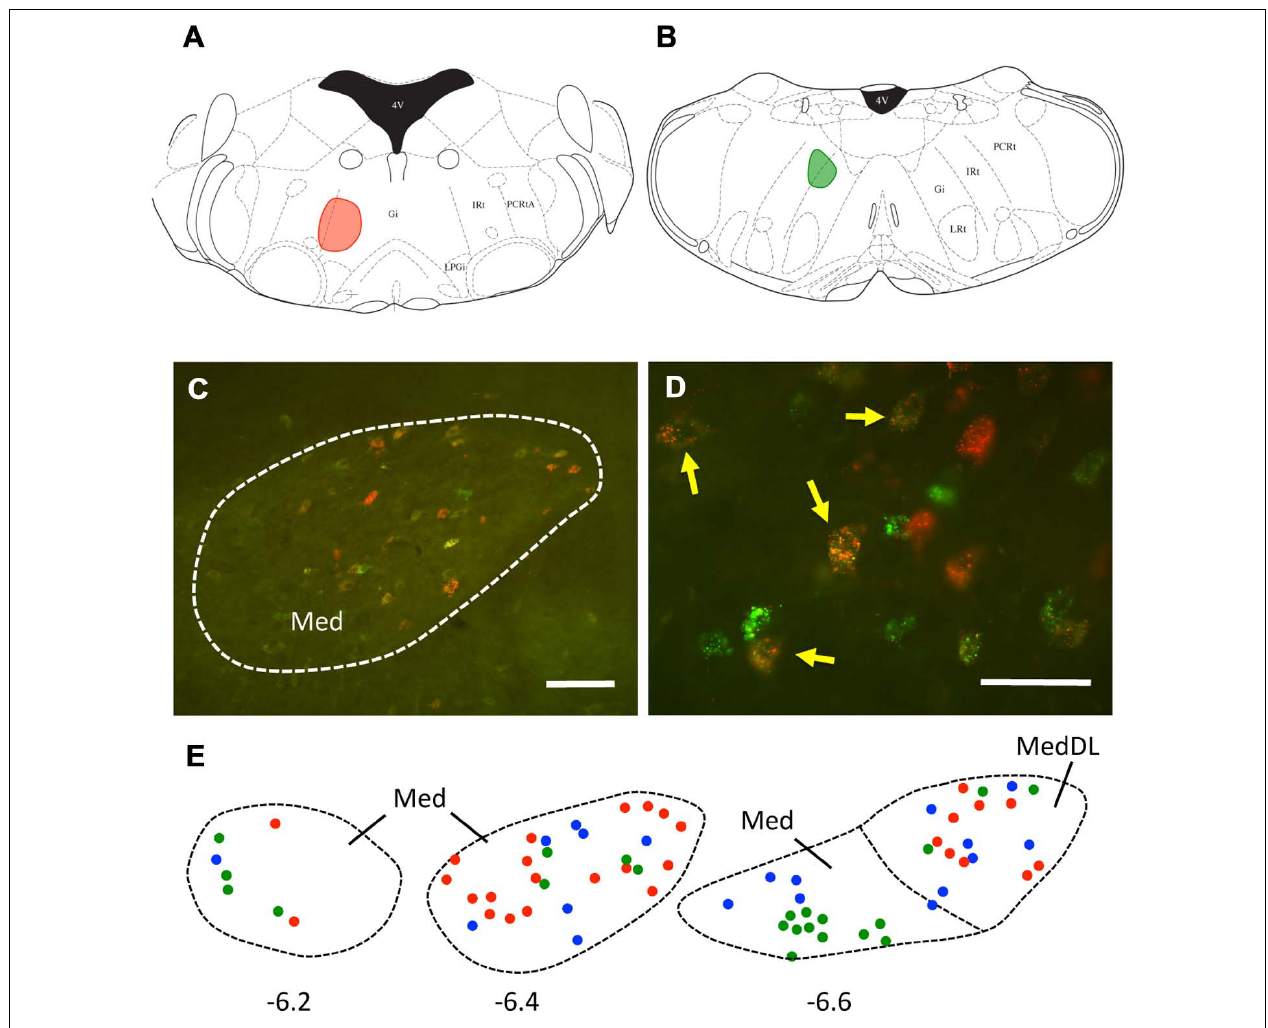
FIGURE 3 |A subset of mDCN neurons collateralize to rostral and caudal locations in the brainstem. (A,B) Plots of injection sites of rostral (red) and caudal (green) fluorescent microspheres in brainstem. (C) Retrogradely labeled mDCN neurons appear green or red, respectively; a subset (yellow) is double-labeled. Labeling is confined to the cell body. (D) High power picture of labeling, showing that double-labeled cells (arrows) could be reliably discriminated from single-labeled cells. Approximate level is − 6.4 mm from